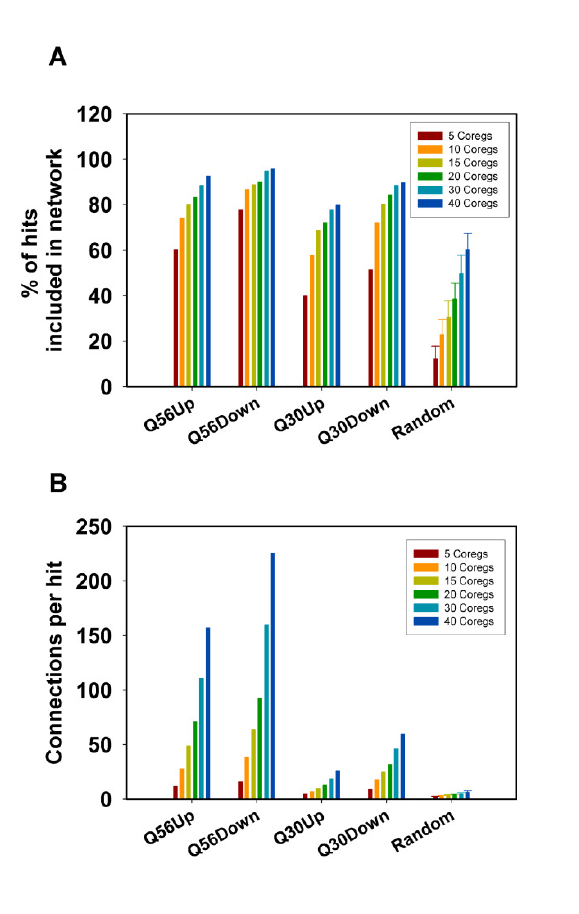
FIGURE 2: Analysis of network connectivity based on the used number of co-regulated genes. Connectivity parameters for hits derived from the Q56- and Q30 datasets were calculated for 100 hits. The best 5-40 co-regulators were obtained from the SPELL data sheets. (A) Depicted are the number of hits, which are in- cluded in the network and (B) the average number of connections per hit. As a control 100 random sets of genes were used and processed in the same manner. The error bars represent the standard deviation for the 100 random gene